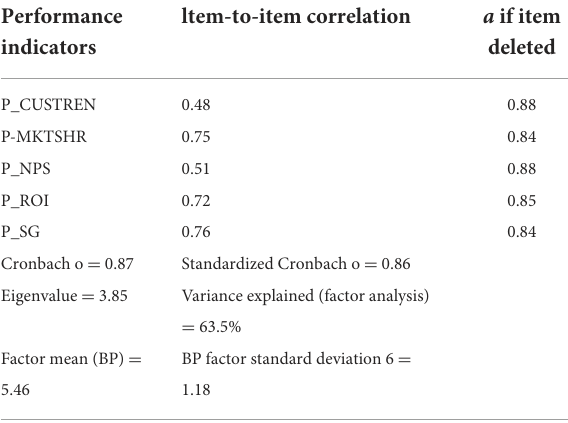
TABLE 5 Reliability examination of business